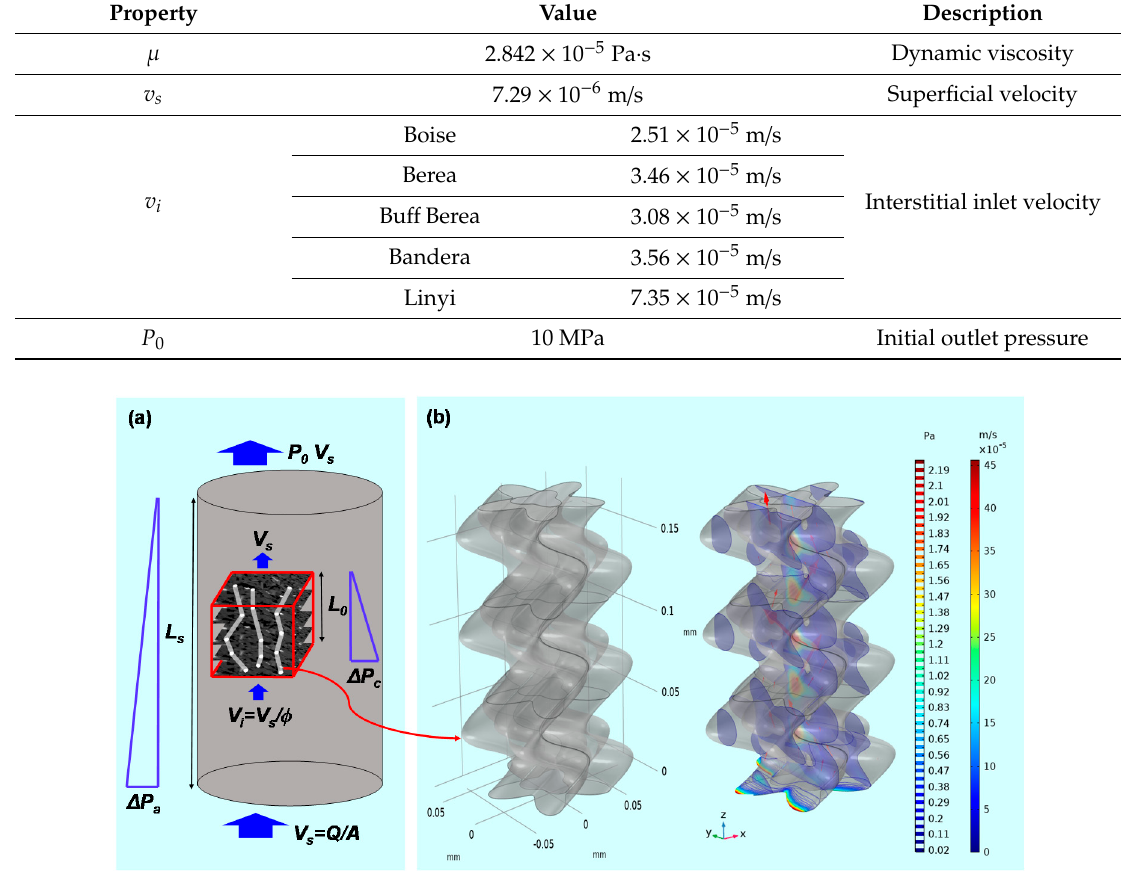
Table 6. Numerical input data corresponding to core flooding experiment using CO 2 .